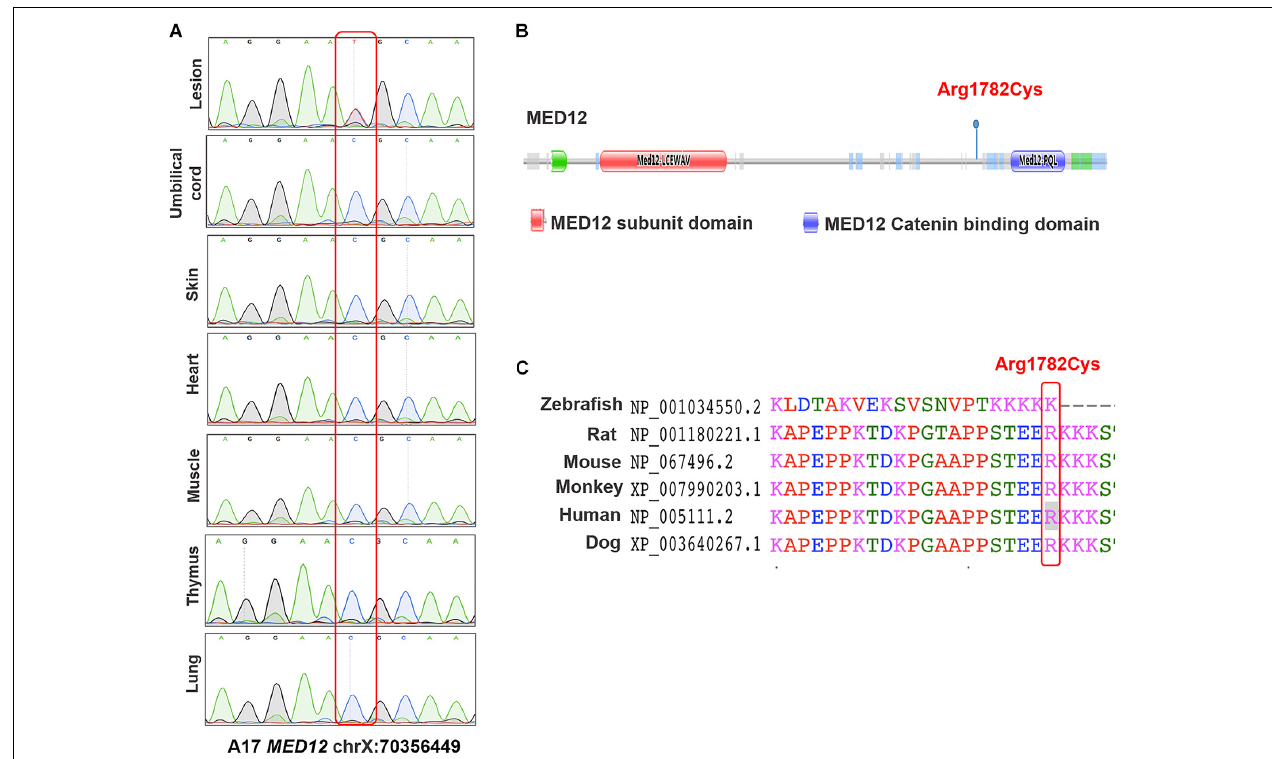
FIGURE 1 | The identified variants of MED12 in human samples. (A) Sanger sequencing map of the MED12 c.5344C > T in different organs. (B) Conserved domains and the total scheme of the target genes and positions of the identified mutations. (C) A partial alignment of human target MED12 protein with other orthologous